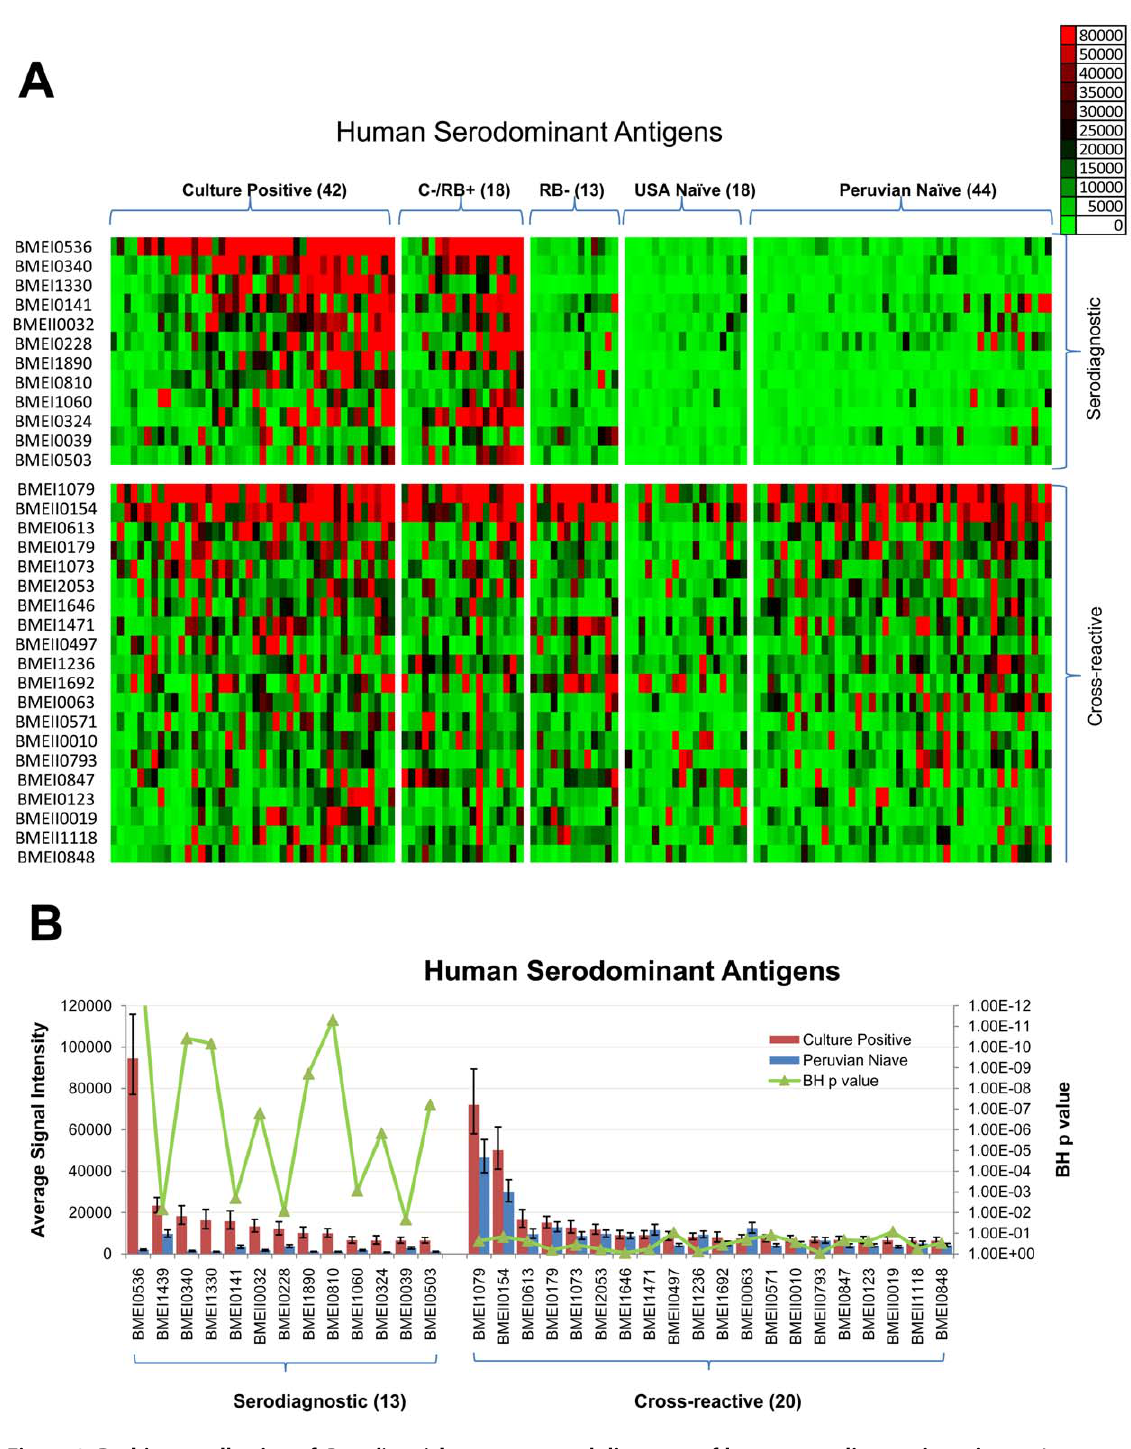
Figure 3. Probing a collection of B.melitensis human sera and discovery of human serodiagnostic antigens. Arrays were probed with human sera organized into 5 groups: Culture Positive, Culture Negative/Rose Bengal Positive, Rose Bengal Negative, USA Naı¨ve, and Peruvian Naı¨ve, as described in the text. (A). Heatmap showing normalized intensity with red strongest, bright green weakest and black in between. The antigens are in rows and are grouped to serodiagnostic and cross-reactive antigens. The human samples are in columns and sorted left to right by increasing average intensity to serodiagnostic antigens. (B) The mean sera reactivity of the 1406 antigens was compared between the Culture Positive and Peruvian Naive groups. Antigens with Benjamini Hochberg corrected p-value less than 0.05 are organized to the left and cross-reactive antigens to the right. The 13 most reactive serodiagnostic and 31 of the most reactive cross-reactive antigens are shown. C 2 /RB + , Culture Positive and Rose Bengal negative; RB 2 , Rose Bengal negative. Numbers in () are case numbers from each group.